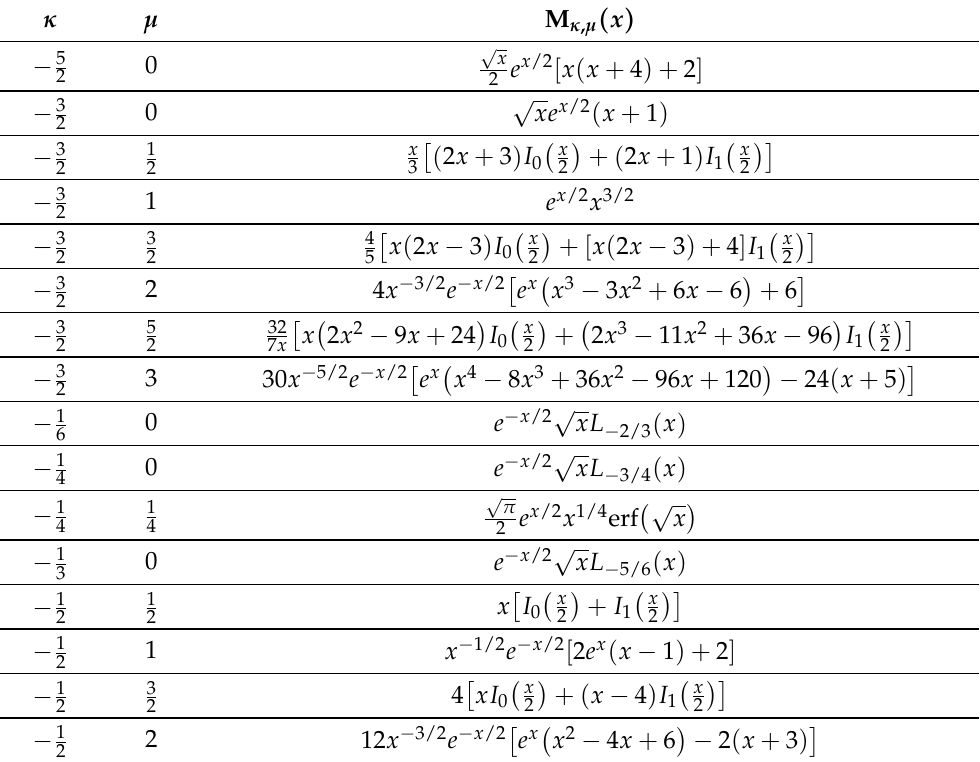
Table A5. The Whittaker functions M κ , µ derived for some values of parameters κ and µ by using